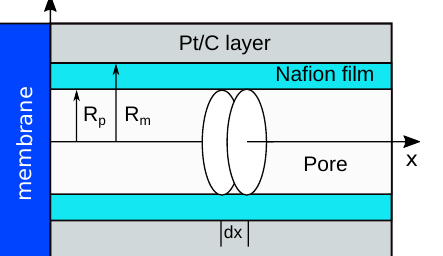
Figure 1. Schematic of a single-pore model for impedance of the low-Pt cathode catalyst